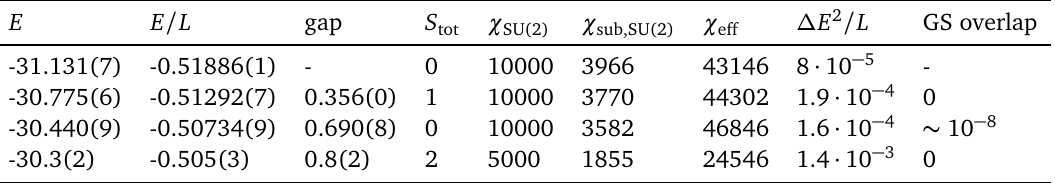
Table 1: Properties of the ground state and the lowest eigenstates: total energy E , energy density E / L , the gap to the ground state, the total spin S dimension χ with spin-SU(2) symmetry, the maximal bond dimension of the SU(2) largest subspace χ , the effective bond dimension χ sub,SU(2) when not exploiting the symmetry, the energy variance per site (Eq. 2), and the overlap with the ground